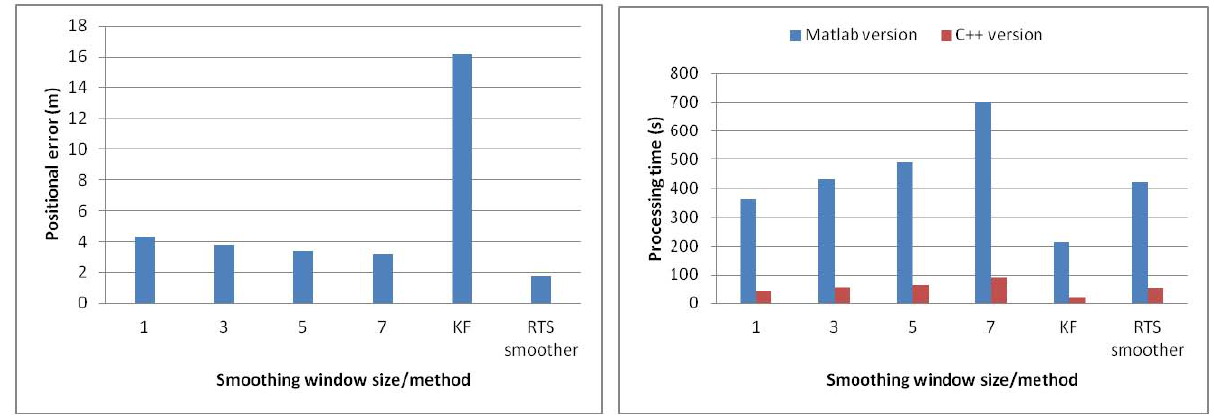
Figure 19. Relationship between smoothing window size and positional error and processing